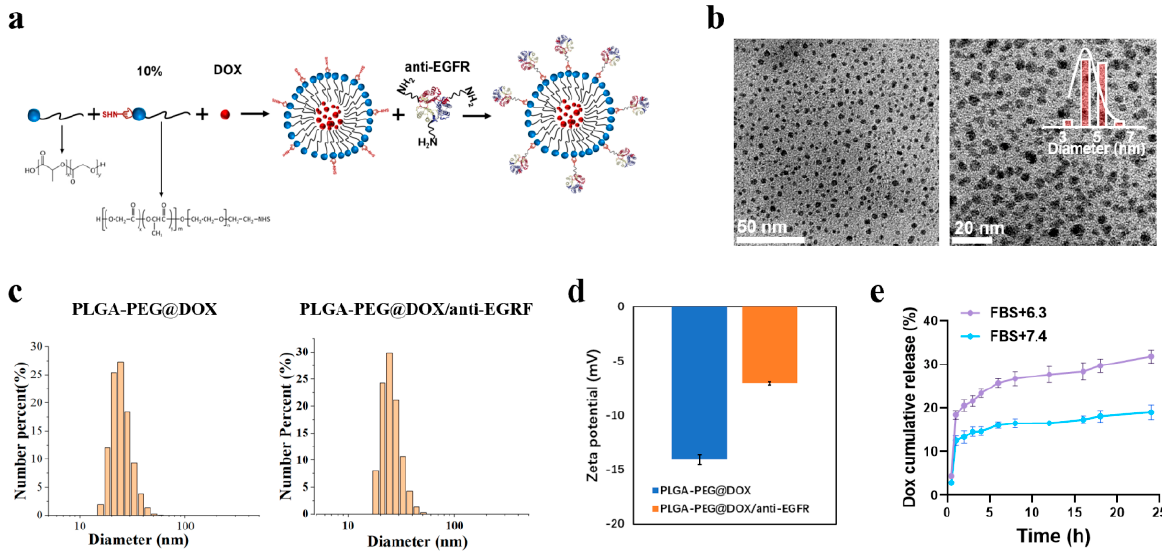
Figure 1. ( a ) PLGA-PEG@DOX/anti-EGFR nano-micelle synthesis strategy. ( b ) PLGA-PEG@DOX/anti-EGFR nano-micelles were assessed via TEM. ( c ) DLS was used to assess PLGA-PEG@DOX and PLGA-PEG@DOX/anti-EGFR nano-micelle size distributions. ( d ) PLGA-PEG@DOX and PLGA-PEG@DOX/anti-EGFR nano-micelle zeta potential values. ( e ) Cumulative DOX release from PLGA-PEG@DOX/anti-EGFR (pH = 7.4 or 6.3) in vitro over the course of 24 h in a 10% FBS solution at 37 °C. Samples were assessed in triplicate.